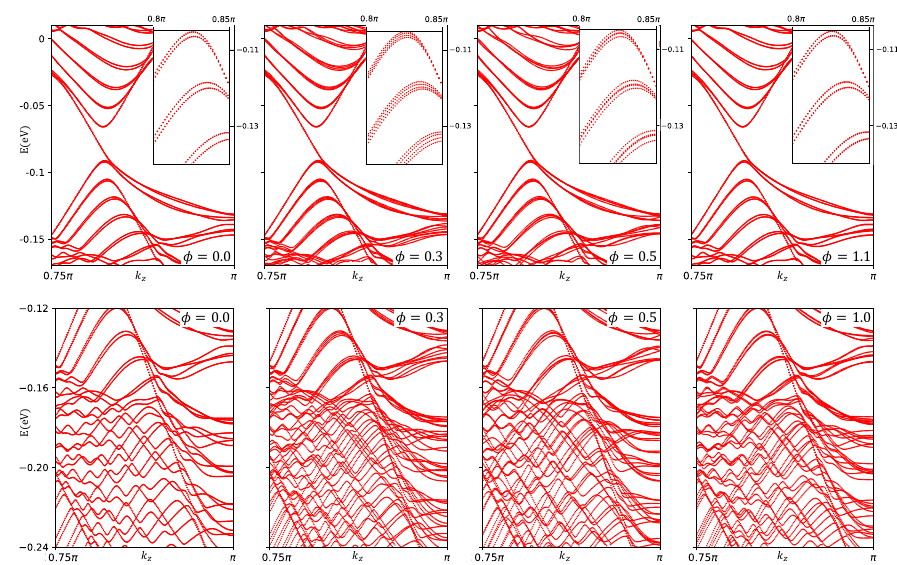
Figure 4: Band structure of the ( 110 ) wire with flux. In all figures, the wire is square with 28 atoms in the outermost layer in both dimensions. Flux value is indicated on each figure. First row: Low energy bands, showing a very weak response the flux. Insets Zoom-in on the lower bands reveal groups of four bands that change degenerate partners under flux sweep. Second row: High energy bands, showing a strong response to